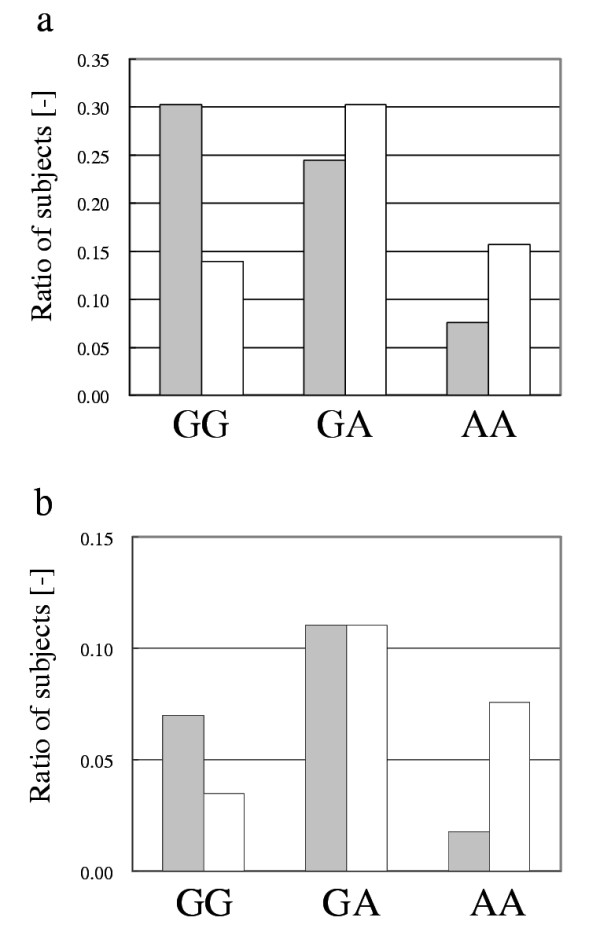
Distribution of IL-4Rα (148 G/A) genotype with CysLT2 (2534 A/G) genotype AG or GG (P = 0.00030) (a), and distribution of C3 (1692 G/A) genotype with IL-10 (-571 C/A) genotype CA and IL-4 (-590 C/T) genotype CT (P = 0.00426) (b). Gray and white bars represent frequency of case subjects and control subjects, respectively.